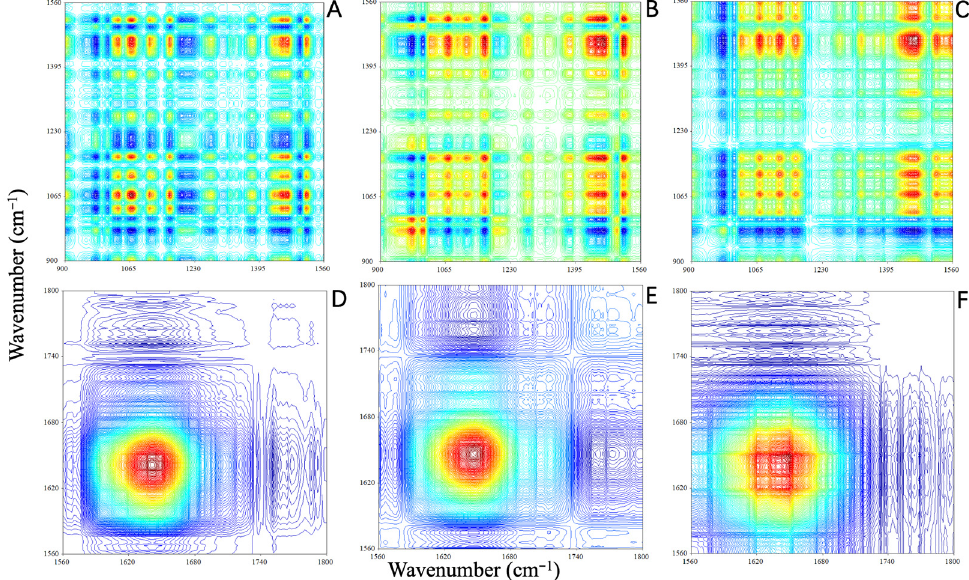
Figure 7. Synchronous 2D COS ‐ IR images of RS, AIS, and AOS in the range of ( A – C ) 900–1560 cm − 1 and ( D – F ) 1560–1800 cm − 1 (red: positive; blue: negative). and ( D – F ) 1560–1800 cm − 1 (red: positive; blue: